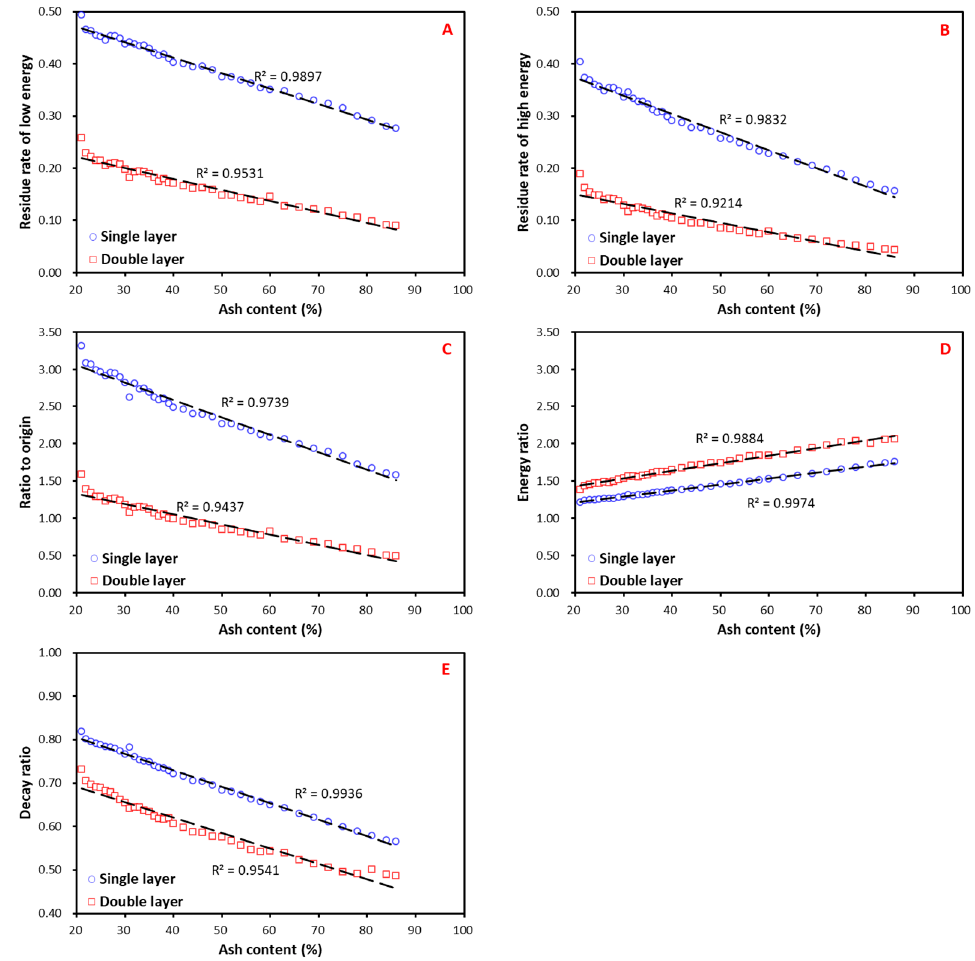
Figure 3. The relationship between ash content and characteristic parameters ( A ): residue rate of low energy; ( B ): residue rate of high energy; ( C ): ratio to origin; ( D ): energy ratio; ( E ): decay ratio.3.2. Optimization of Wave Filter.